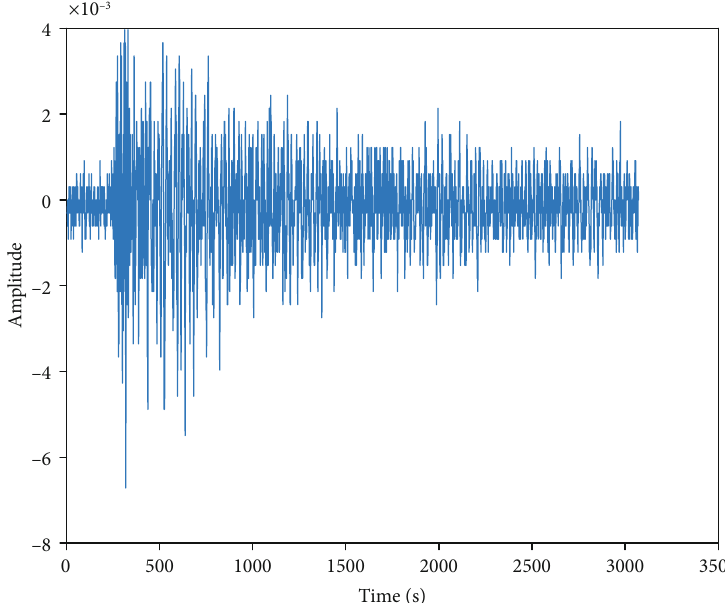
Figure 5: Time-domain graphic of the original signal. Time-domain fi gure obtained through processing the signals collected by the acoustic emission equipment.